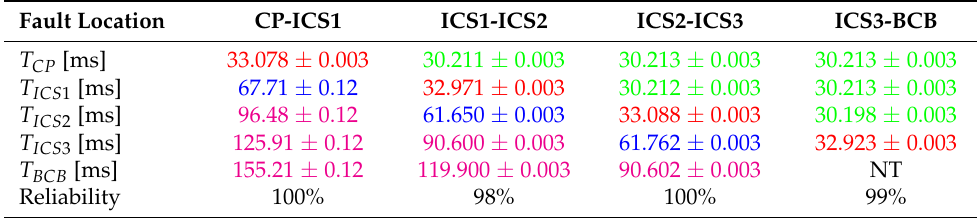
Table 7. Results obtained with SF = 9 and BW = 500